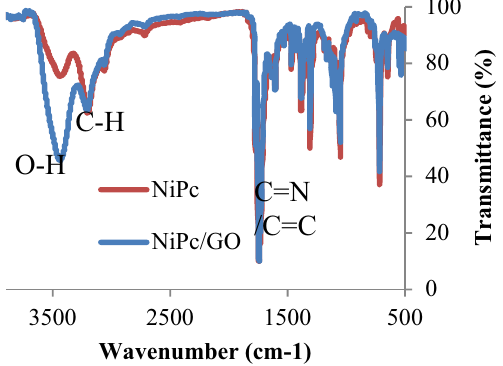
Figure 1. FT-IR spectra of NiPc and